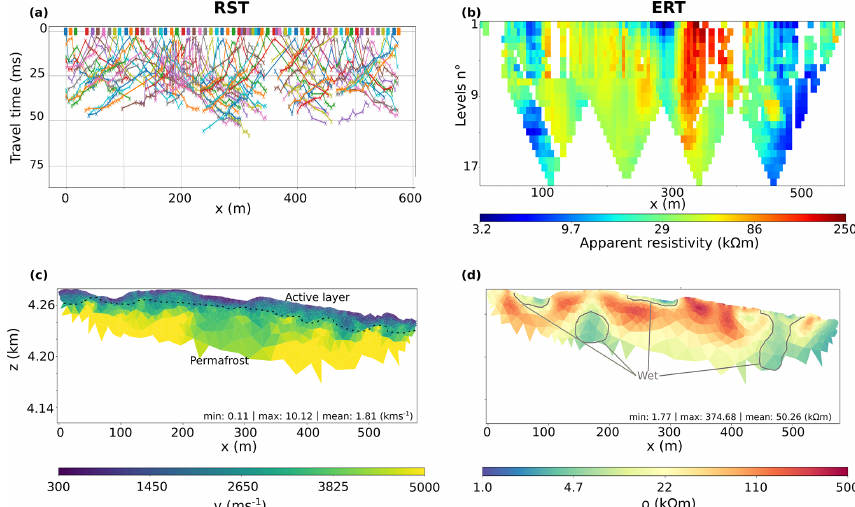
Figure 6. Geophysical observations and inversion model results for the El Ternero rock glacier. (a) RST first arrival travel times. (b) ERT apparent resistivity. (c) Velocity and (d) resistivity tomograms. The velocity model is cut below the lowermost ray path, while the resistivity model transparency is proportional to the ERT data coverage. The velocity colour bar is linear, while the resistivity one is expressed in logarithmic scale.